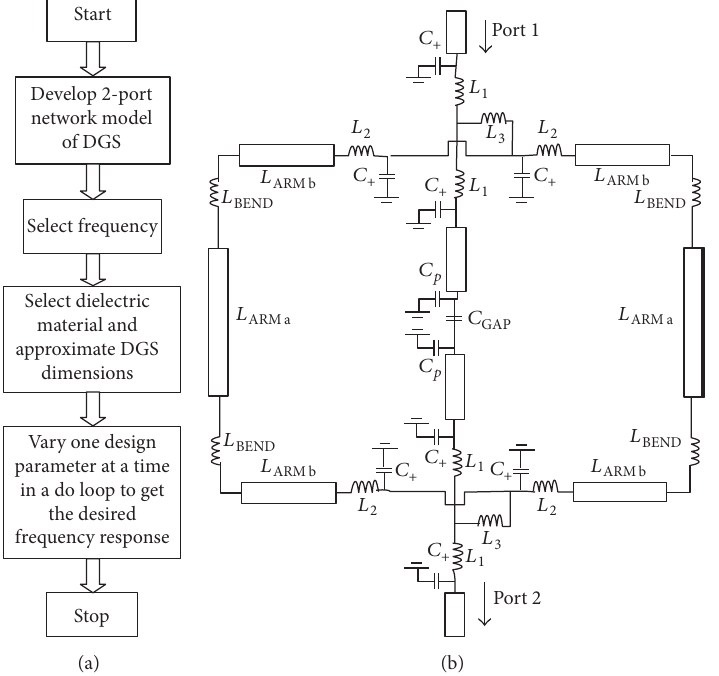
Figure 7: New design and analysis method of DGS: (a) analysis method of DGS; (b) equivalent circuit model of unit cell DGS [32].